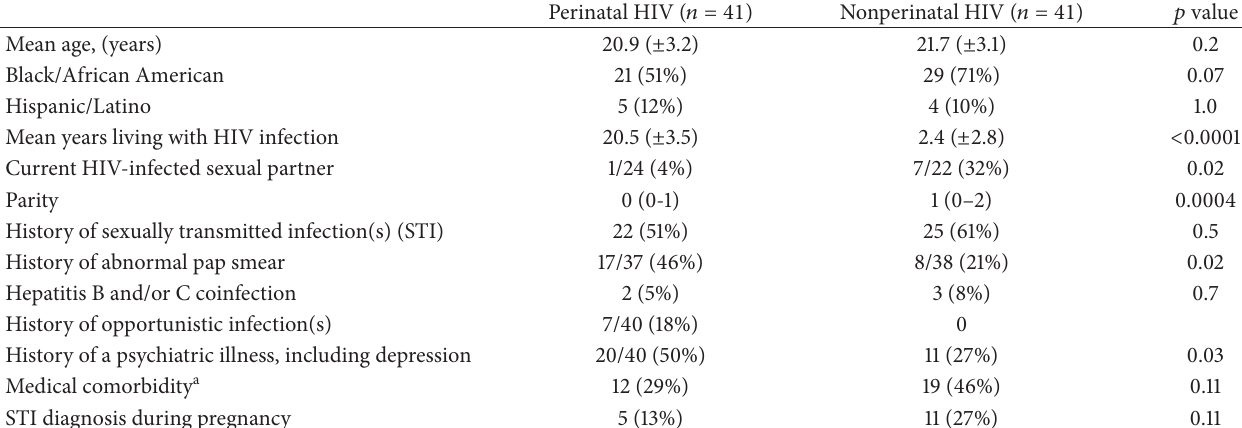
Table 1: Maternal characteristics of pregnant women with perinatal and nonperinatal HIV infection.